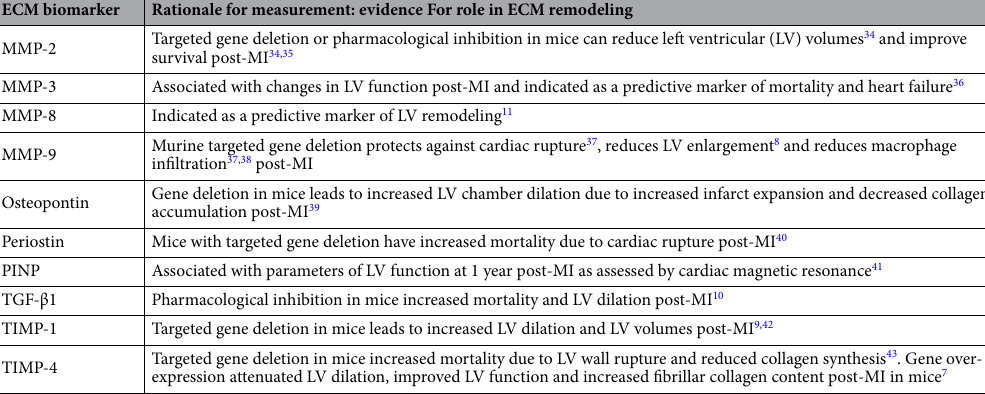
Table 5. Evidence for ECM biomarker role in ECM remodeling